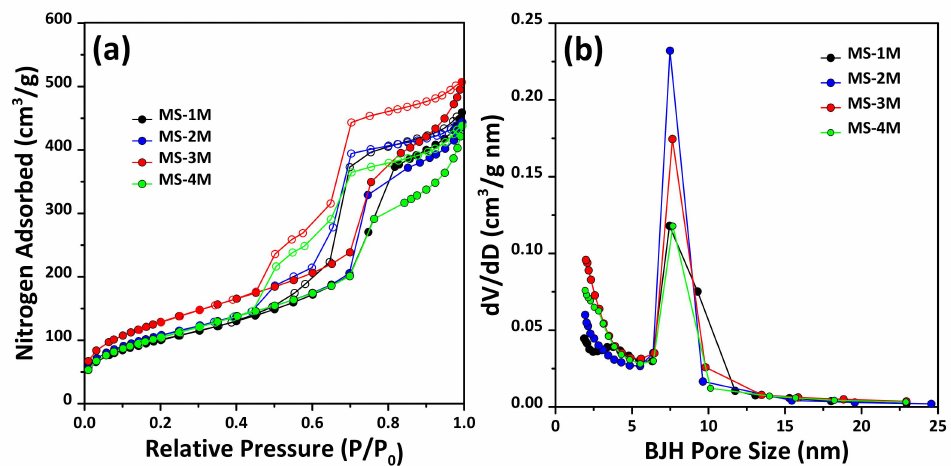
Figure 4. ( a ) Nitrogen adsorption–desorption isotherms and ( b ) pore size distributions of MS-1M, MS-2M, MS-3M and MS-4M, respectively. The isotherms have not been offset. Solid circle and empty circle symbol represent adsorption and desorption curve, respectively. Pore size distributions derived by using BJH mesopore analysis from the nitrogen adsorption isotherms are presented in ( a ). Table 2. Physical properties, silanol (Si-OH) and sulfur content of the synthesized MS obtained in this study. Sample